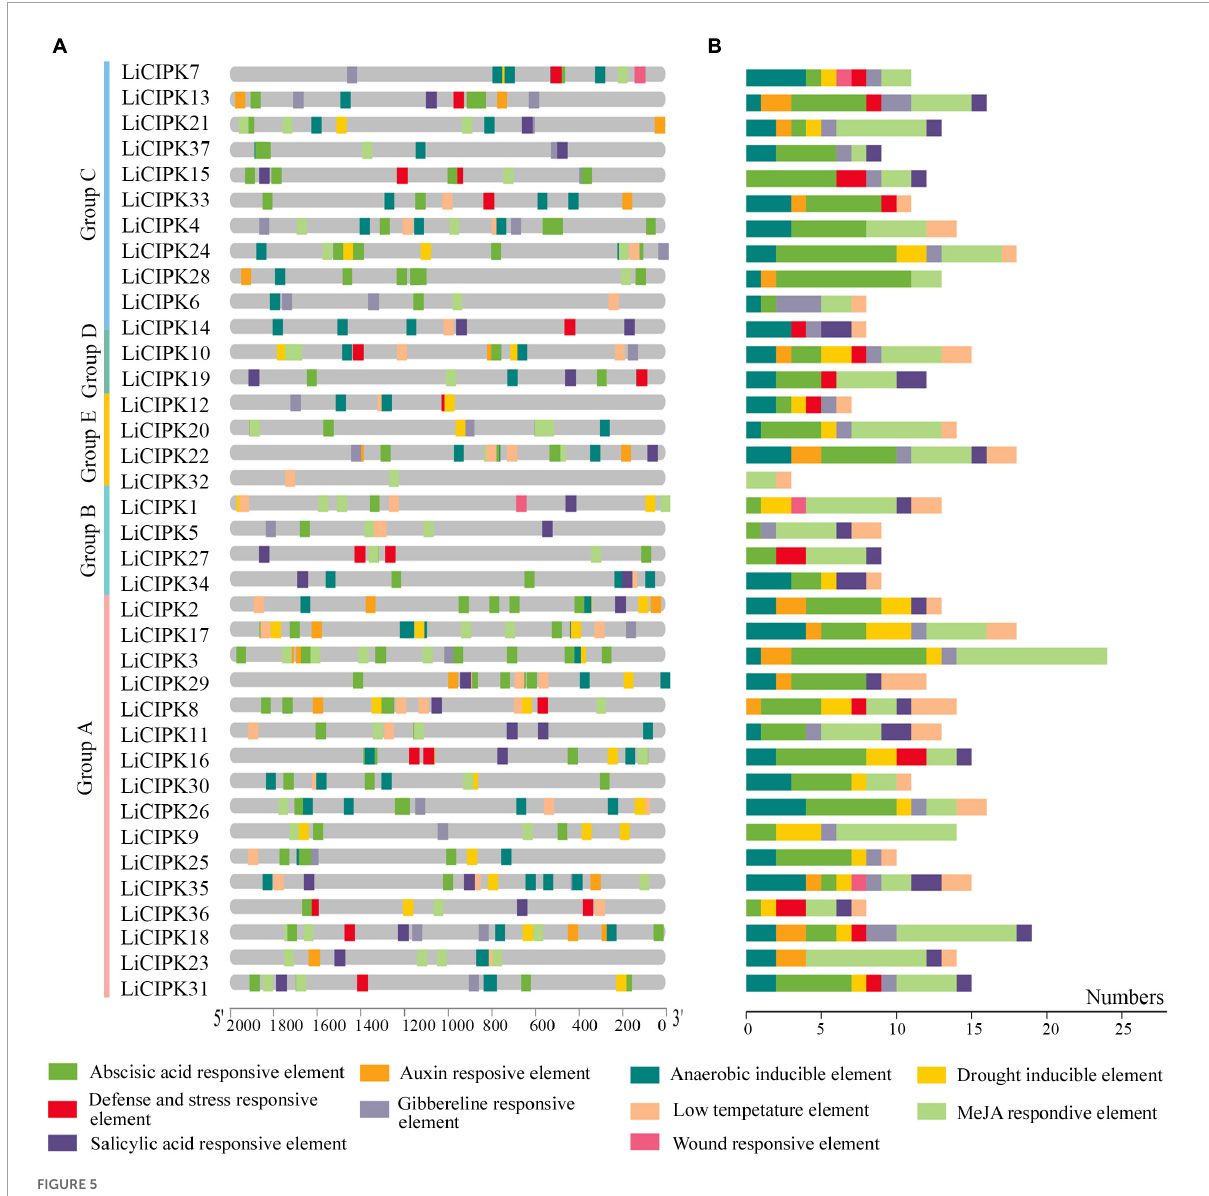
FIGURE5 Distribution and numbers of abiotic stress and hormone responsive cis -elements in promoters of LiCIPK s. (A) The distribution of different cis -elements. (B) Numbers of different cis -elements. Elements are indicated as rectangles, others sequences as